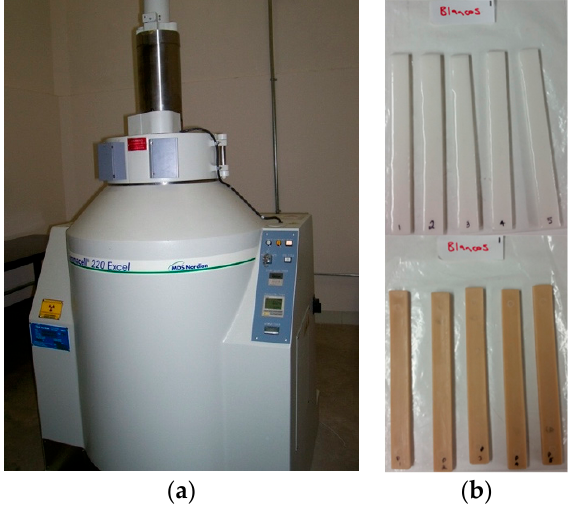
Figure 1. ( a ) MDS Nordion Gammacell 220 Excel irradiator (courtesy of UNISON, México); ( b ) ZnO- epoxy composite samples before (white) and after (brown) UV and gamma irradiation.